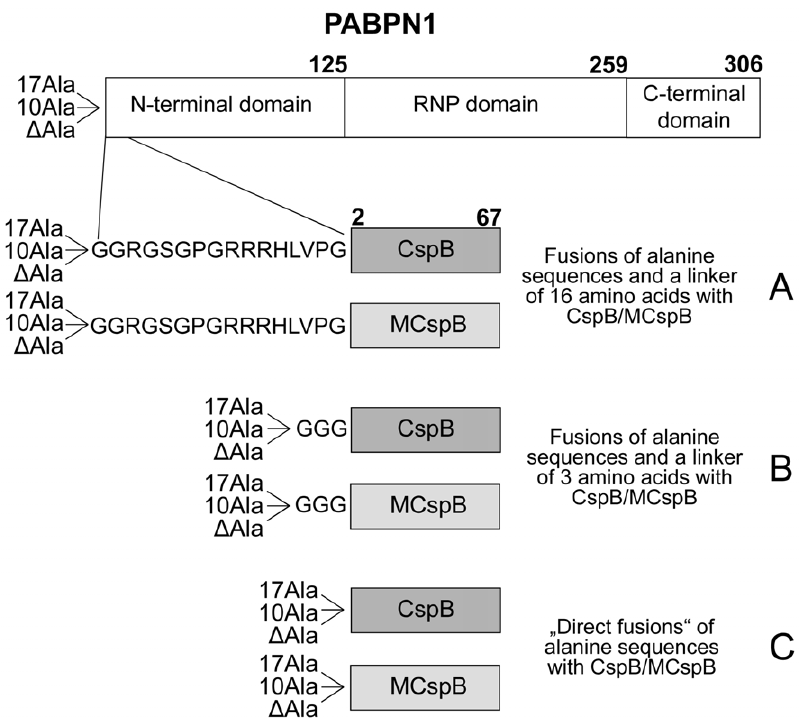
Figure 1. Schematic representation of the fusions analyzed in this work (modified according to [ 19 ] ). For all linkers and CspB mutants, three N-terminal fusions were produced: 17Ala corresponds to the most extreme alanine extension observed in man, 10Ala presents the wild type sequence and D Ala is a negative control. The alanine peptides are followed by the tripeptide GAA.